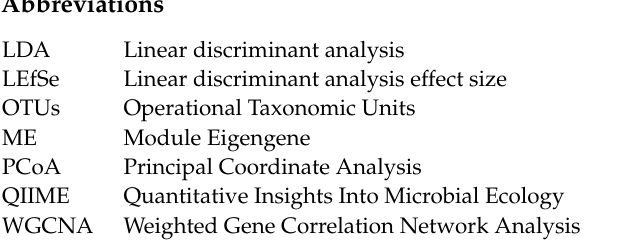
Supplementary Figure S2: Relative abundance of gut microbial phyla, Supplementary Table S1: The comparison of gut microbiota at the phyla level between food-allergic children and non-food allergic children, Supplementary Table S2: Relative abundance of predominant genera in gut microbiota between food-allergic children and non-food allergic children ( ≥ 1% across all samples), Online Supplemental